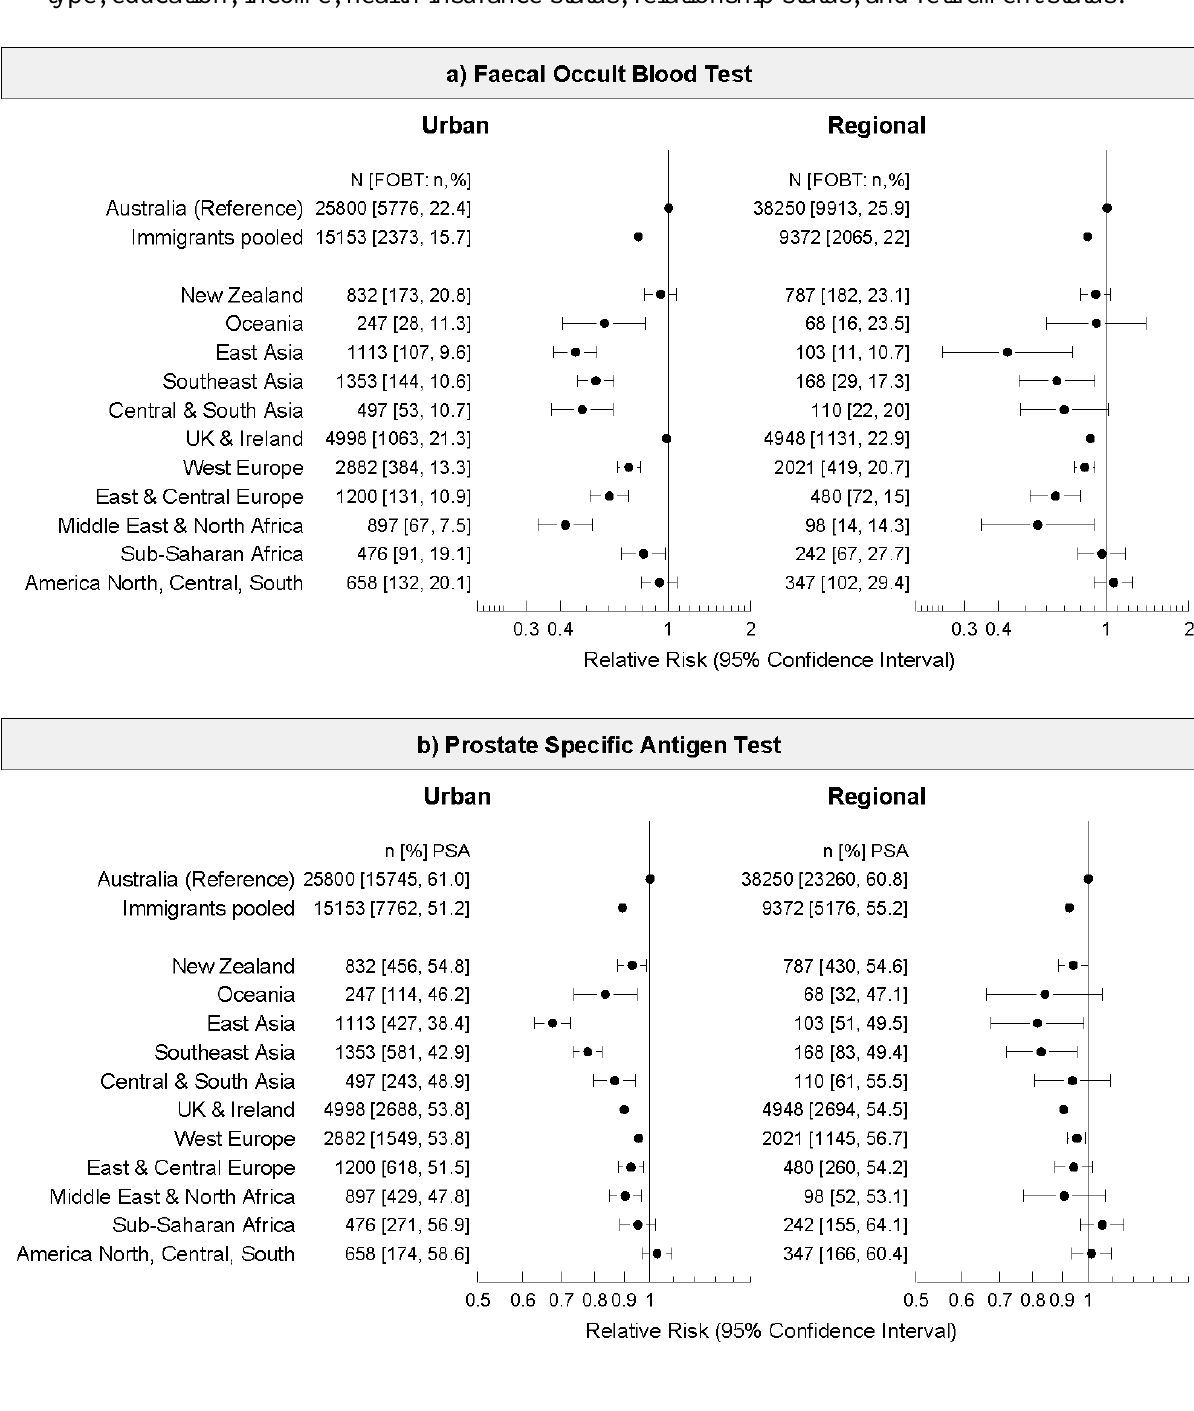
Figure 1. Relative Risk and 95% confidence intervals of ( a ) faecal occult blood test (FOBT), and ( b ) prostate specific antigen (PSA) test use, in the last two years among men living in urban and regional areas of New South Wales, Australia by place of birth in the 45 and Up Study (2006–2010). Relative risks adjusted for age, family history of any cancer type, education, income, health insurance status, relationship status, and retirement